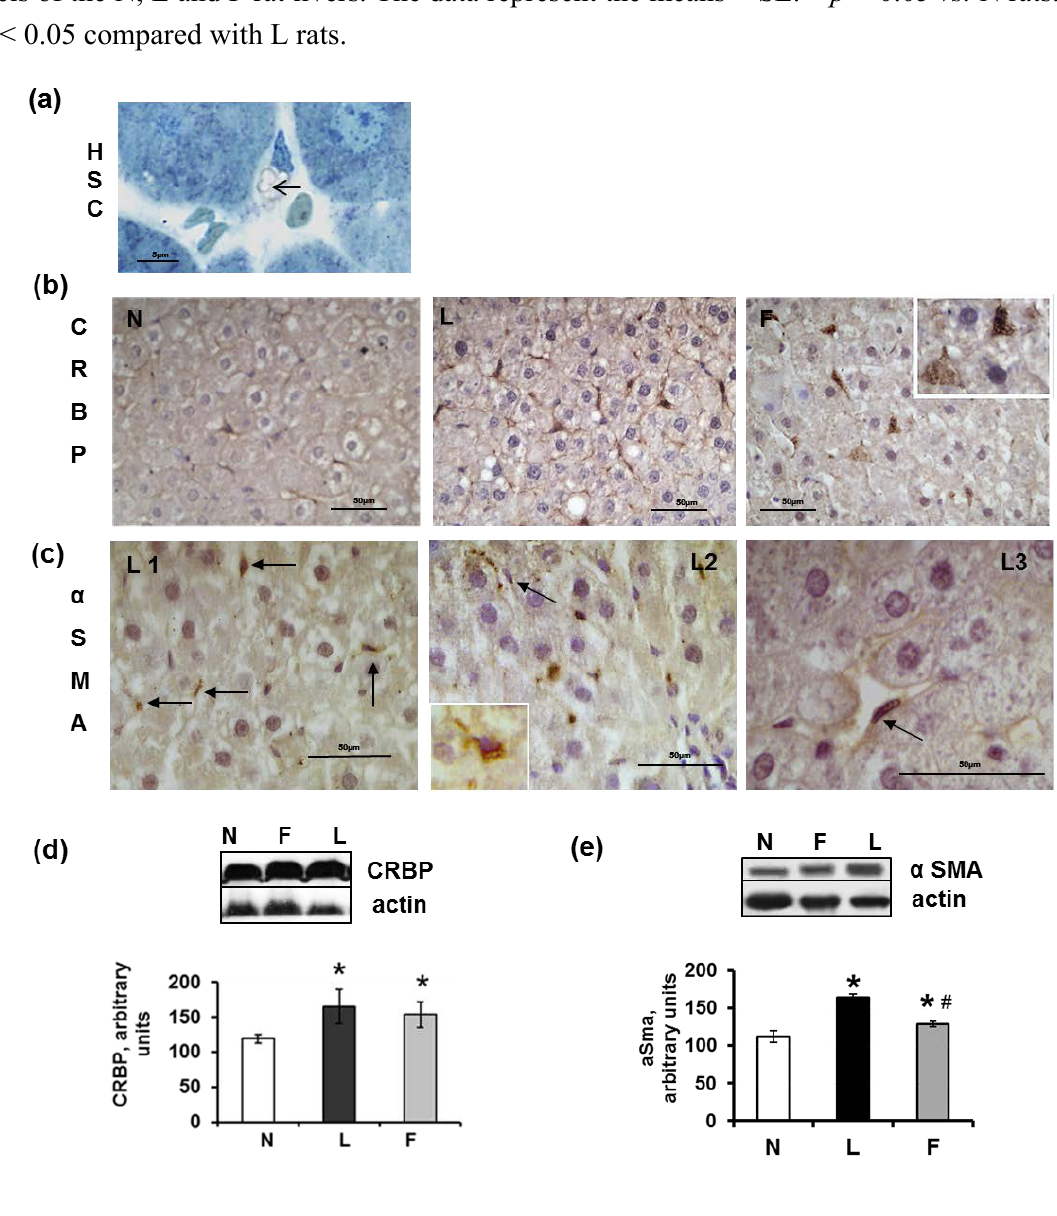
Figure 6. Hepatic stellate cells (HSC) in sections from rats fed a control diet (N), high-lard diet (L) or high-fish oil diet (F). ( a ) Semi-thin section of an N liver that shows the cytoplasm of an HSC that is filled with lipid droplets (arrow); ( b ) N: CRBP-immunoreactive cells (HSCs) appeared to form a network around the N hepatocytes. L: CRBP-immunoreactive cells appeared to be more numerous than those of the N rats. F: strong positivity for CRBP in HSCs. The inset shows a higher magnification of CRBP-immunoreactive HSCs that are present in the Disse space; ( c ) L1 and L2: The arrows indicate the positivity for α-SMA in elongated cells of the walls of blood vessels. L3: A higher magnification of an α-SMA-positive HSC; ( d ) Representative Western blot analysis of CRBP and corresponding densitometric analyses on the relative protein levels in the N, L and F rat livers. The data represent the means ± SE. * p < 0.05 vs. N rats; ( e ) Representative Western blot analysis of α-SMA and corresponding densitometric analyses on the relative protein levels of the N, L and F rat livers. The data represent the means ± SE. * p < 0.05 vs. N